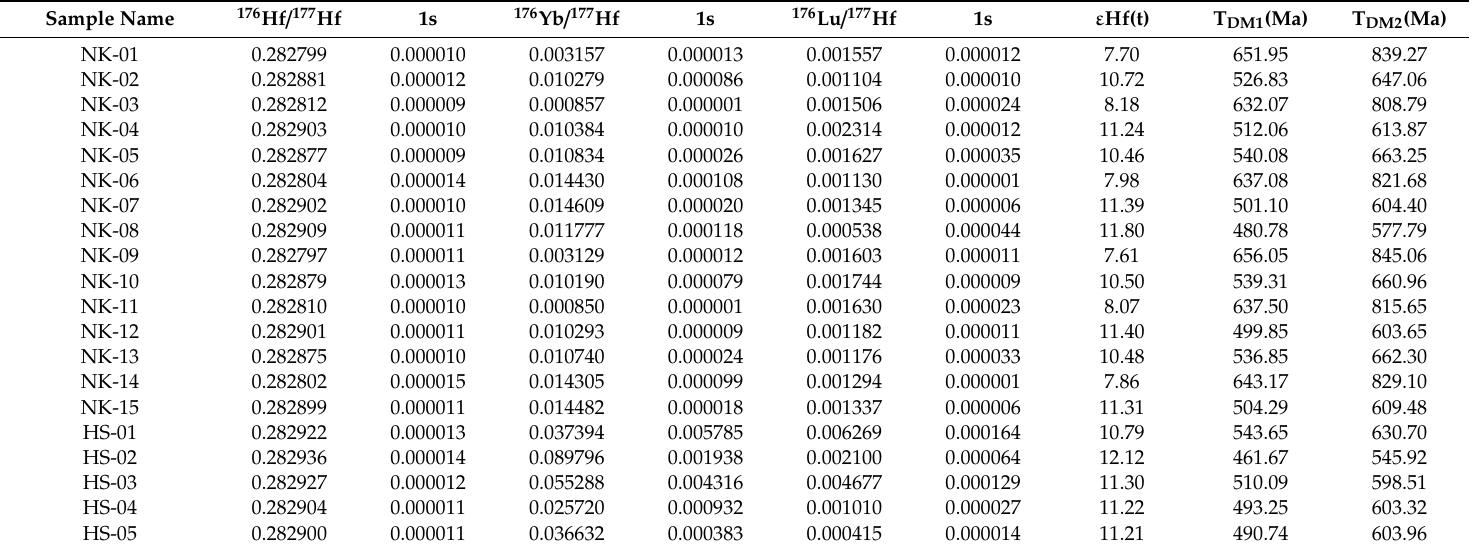
Table 5. Hf isotopic compositions of the North-Karamay granitoids and the Hongshan